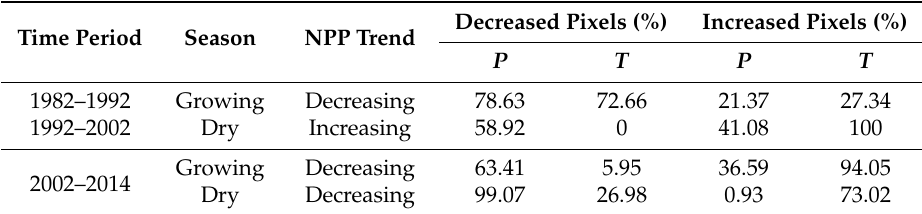
Table 5. The percentage of decreased and increased pixels of precipitation and temperature within the area showing the same variation trends as the seasonal